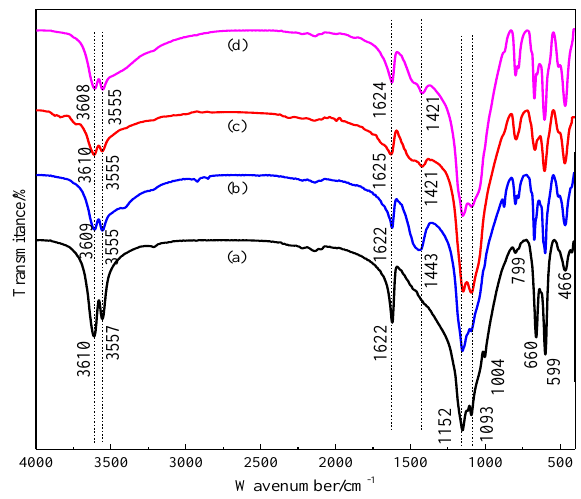
Figure 12. Fourier transform infrared spectroscopy (FTIR) spectra of CaSO 4 · 0.5H 2 O particles prepared with different crystal modifiers. ( a ) Blank test; ( b ) L-Asp; ( c ) PA; and ( d ) MA.